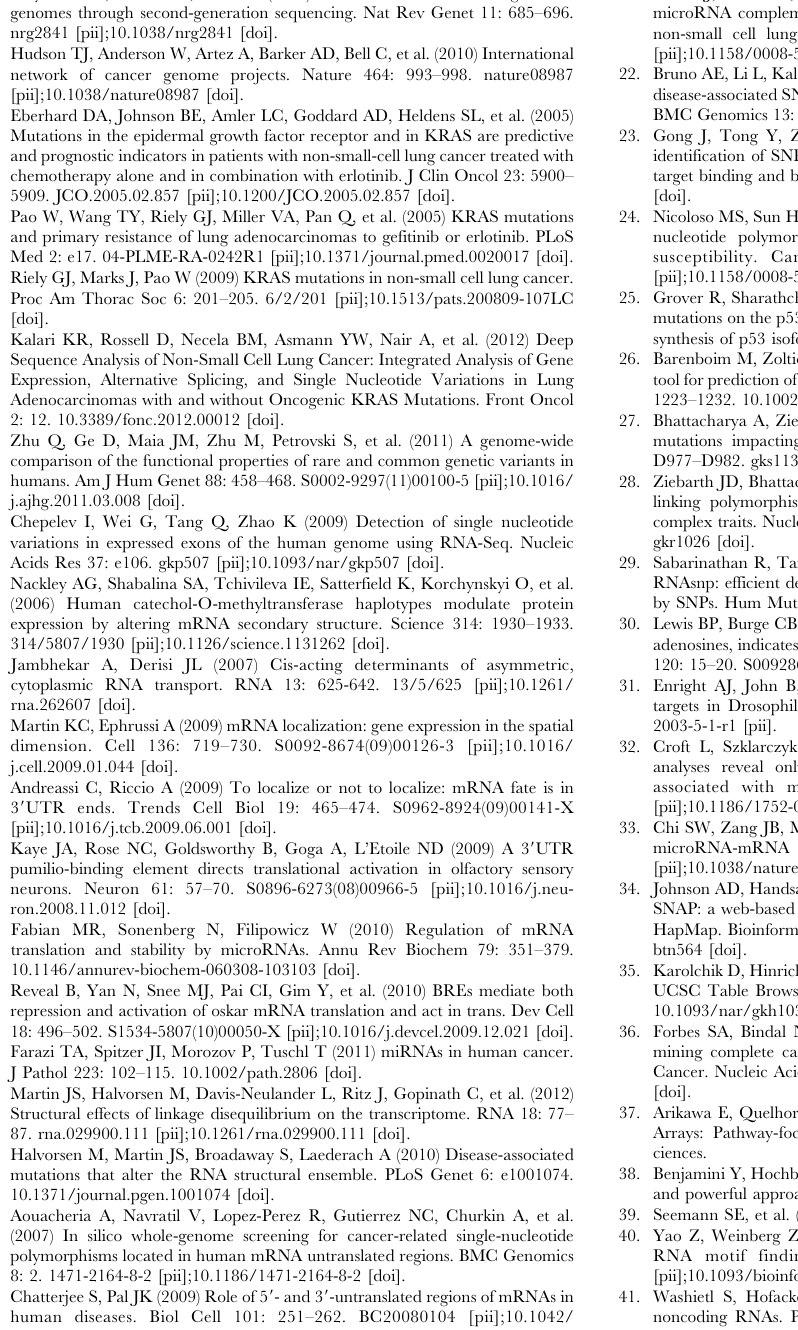
File S4 Candidates from miRNA analysis. Excel table listing 490 SNVs in 447 genes predicted to affect target sites of 344 miRNAs, with indication of cancer-association genes and lung cancer-associated miRNAs . Table S1 Filtration steps in the miRNA pipeline tested on known